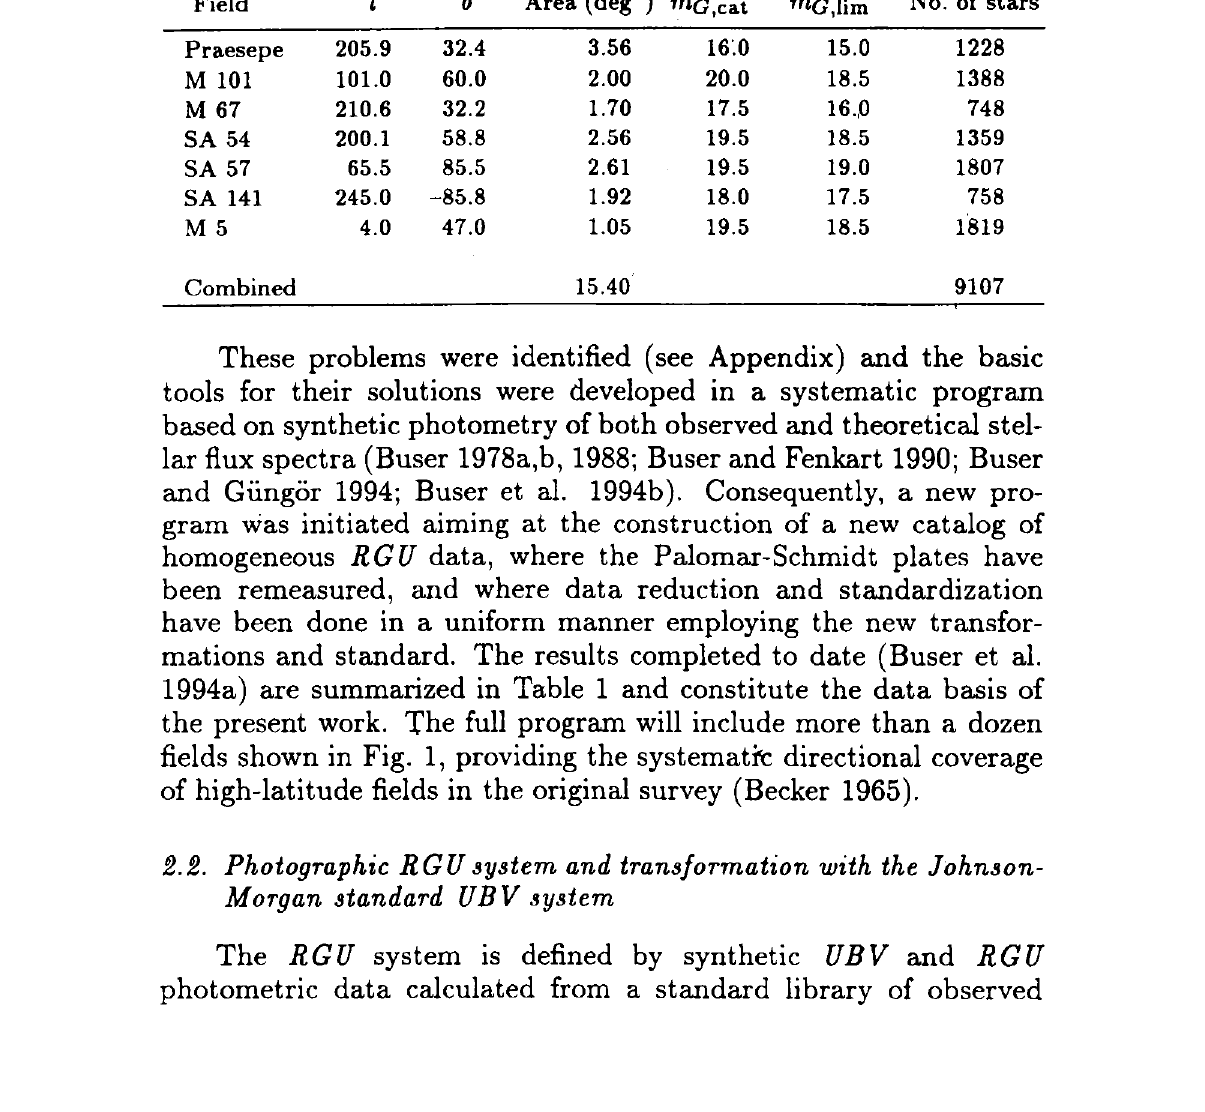
Table 1. Homogeneous Basel high-latitude survey field data